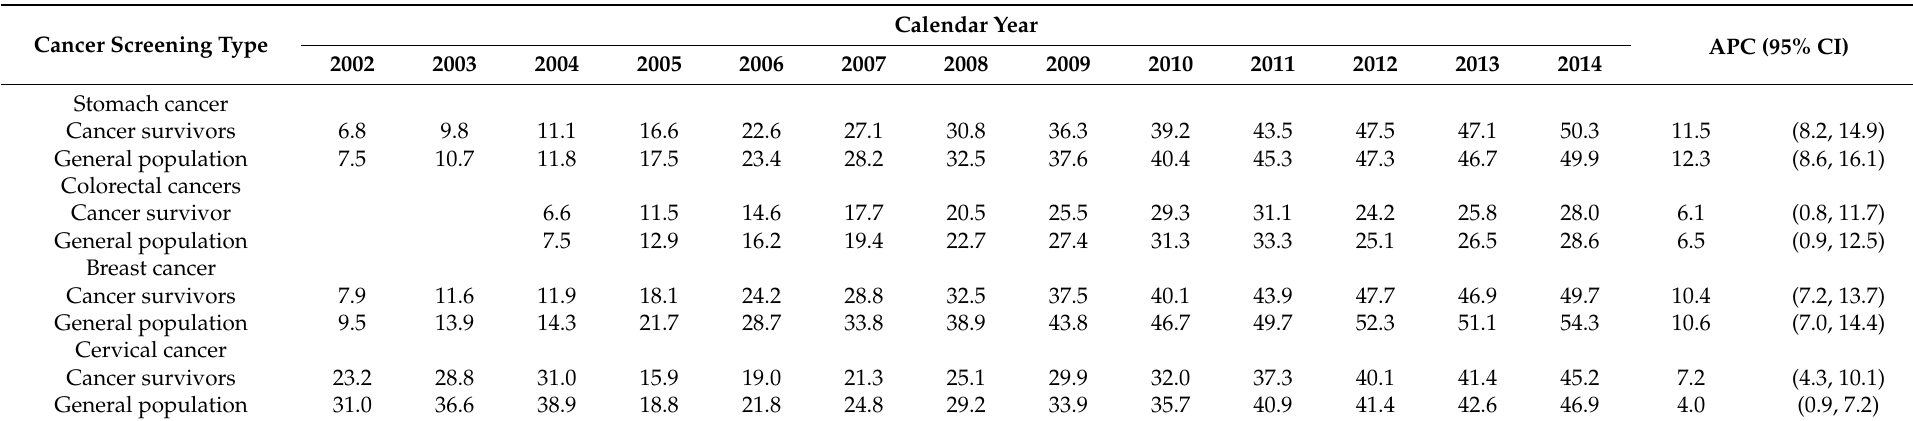
Table 2. Trends in participation rates (%) of the NCSP among cancer survivors and the general